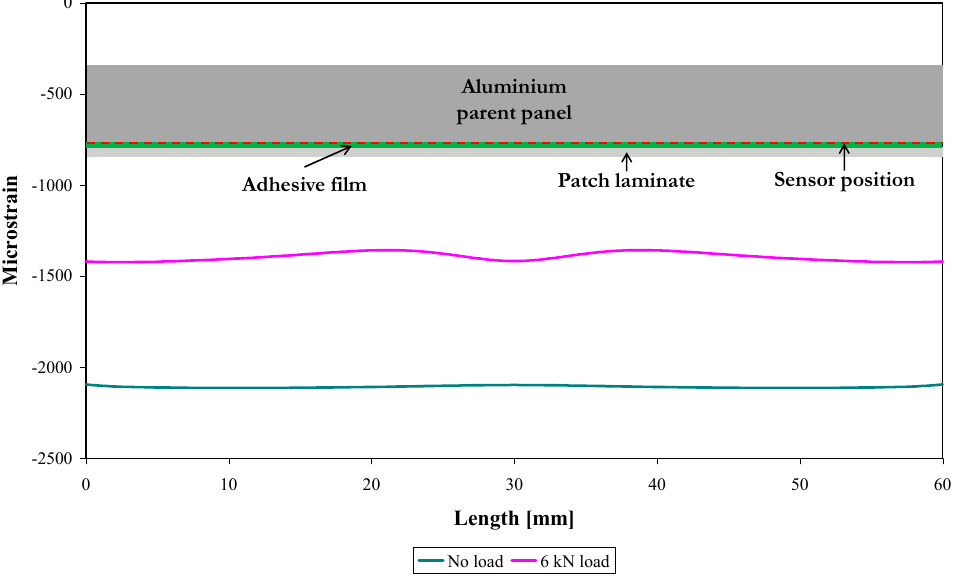
Figure 10. Predicted strain profiles along the position of the 60 mm sensor of the undamaged model when loaded at 0 kN and 6 kN.